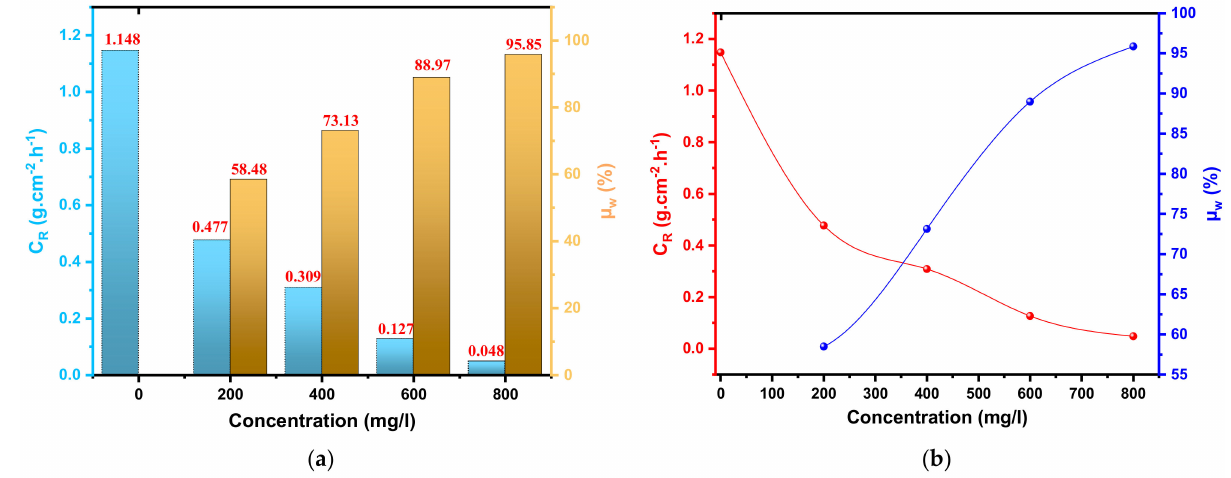
Figure 2. The evolution of inhibitory efficiency and corrosion rate in 1 M HCl without and with Artemisia herba-alba biopolymer CHA ( a , b ).